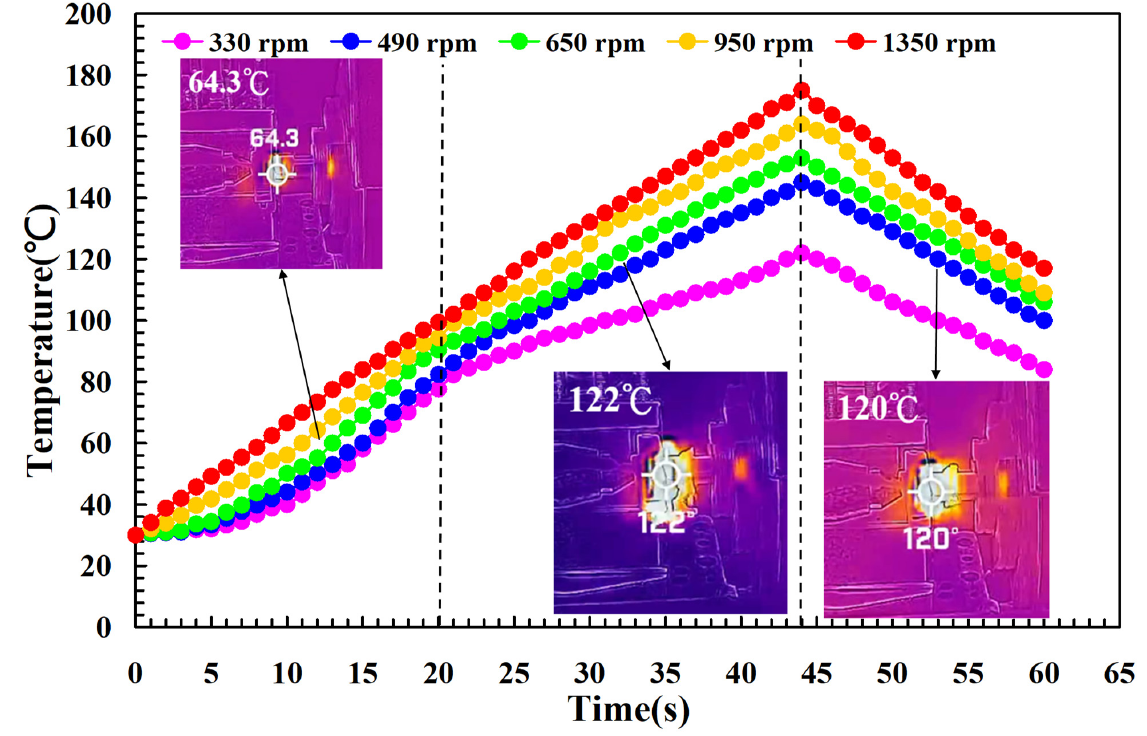
Figure 10. The relationship between weld-joint temperature and FW time for the PLA and ABS rods at five different rotational speeds.